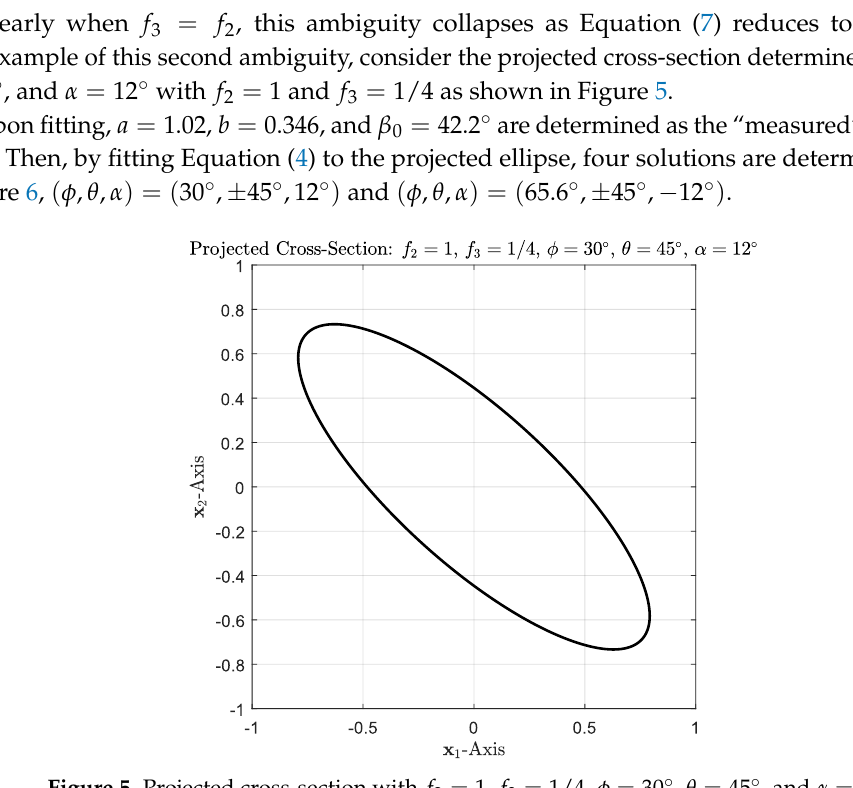
Figure 5. Projected cross-section with f 2 = 1, f 3 = 1/4, φ = 30 ◦ , θ = 45 ◦ , and α = 12 ◦